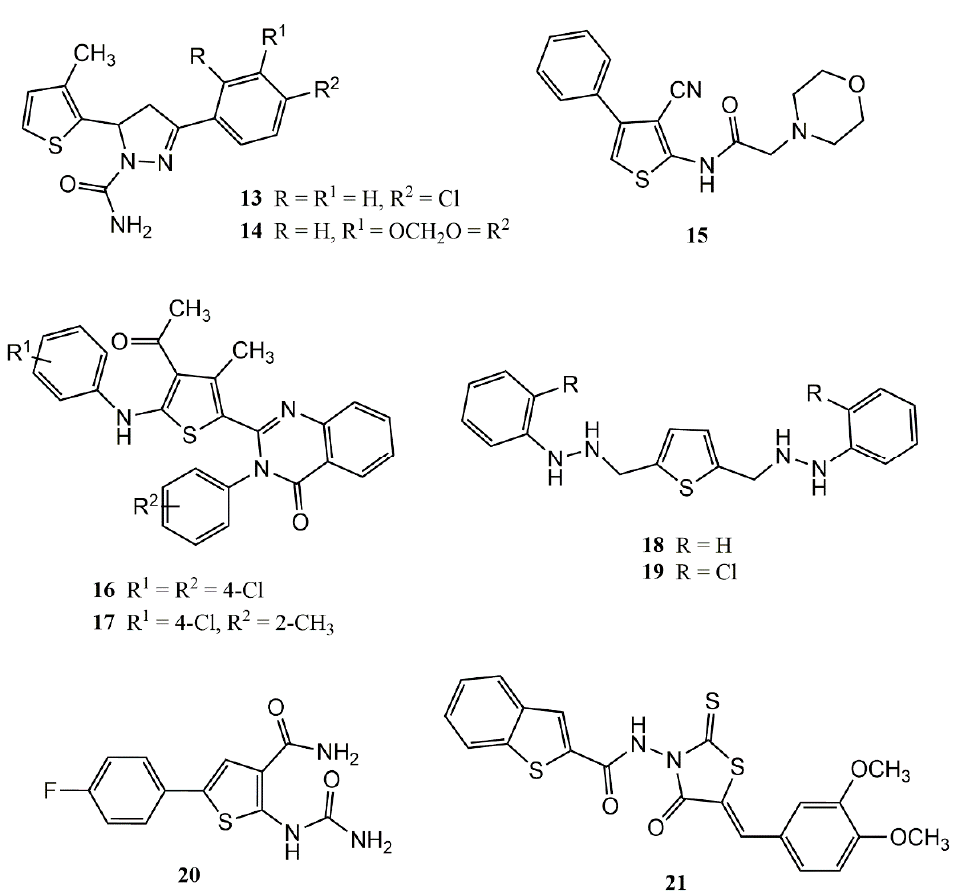
Figure 5. Chemical structures of thiophene-based compounds with anti-inflammatory properties in classic models of inflammation.